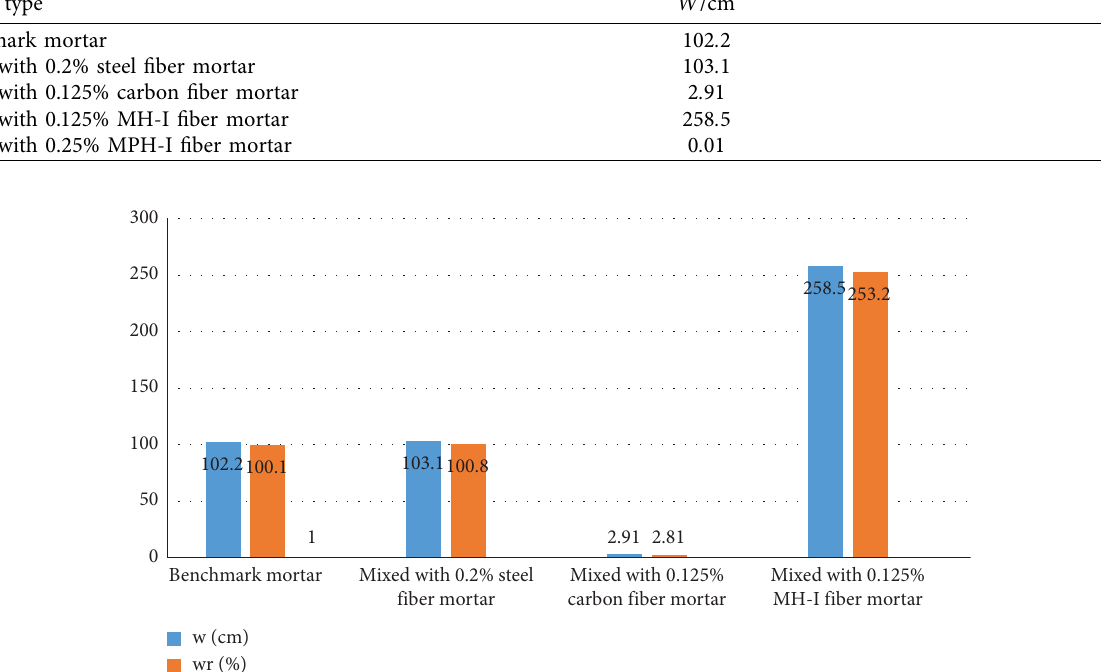
Figure 1: Efect of hardened anticracking fbers on plastic shrinkage cracking. Table 7: Efects of MPH-I fbers on the physical and mechanical properties of mortar concrete. Type of material